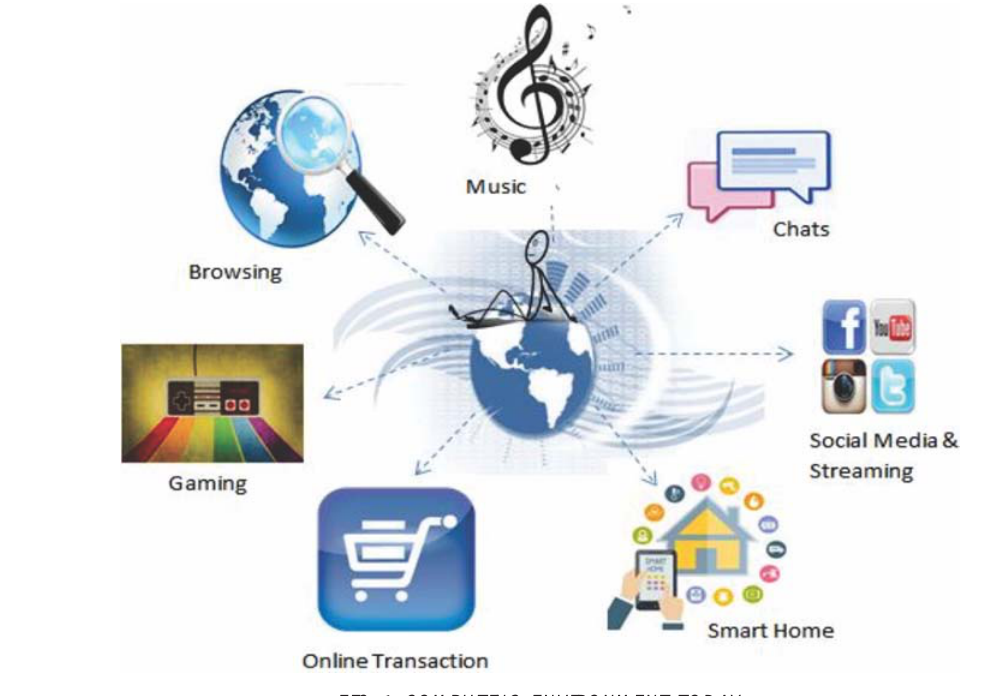
FIG. 1. COMPUTING ENVIRONMENT